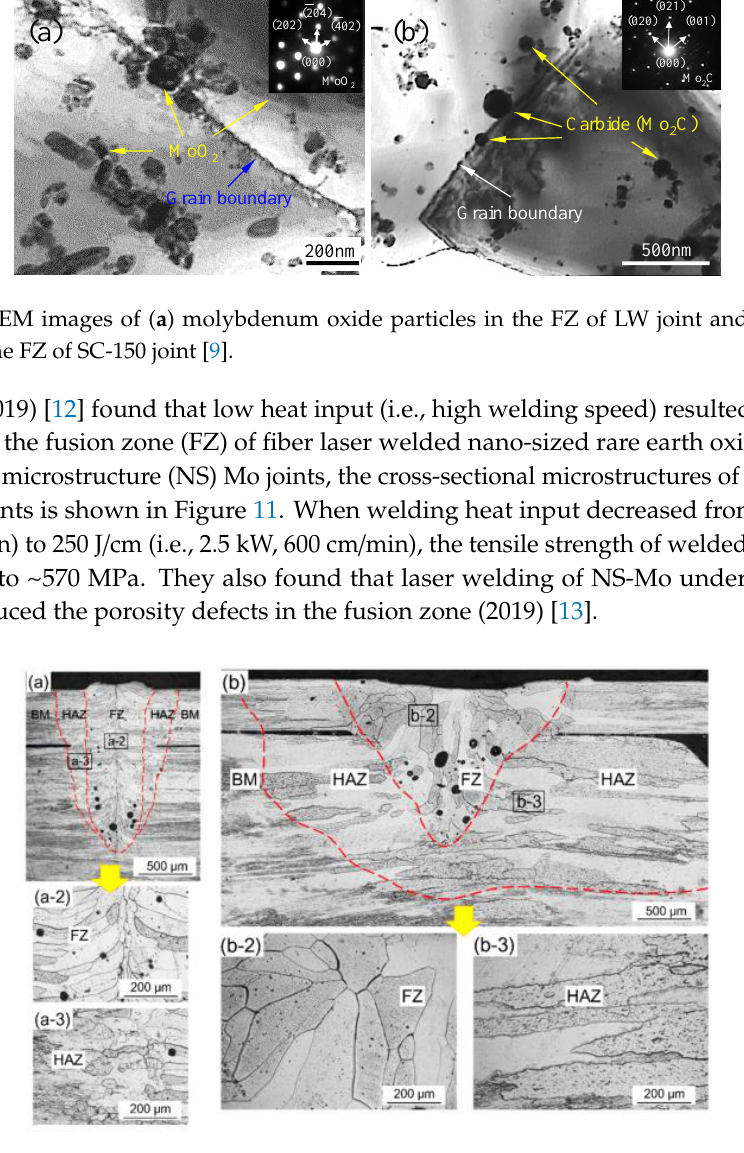
Figure 11. The cross-sectional microstructures of the NS Mo alloy laser welding joints. Heat input: ( a ) 250 J/cm and ( b ) 3600 J/cm [12].